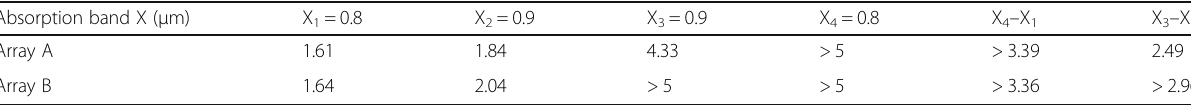
Table 4 High absorption band of arrays in Fig. 8 Absorption band X ( μ m)